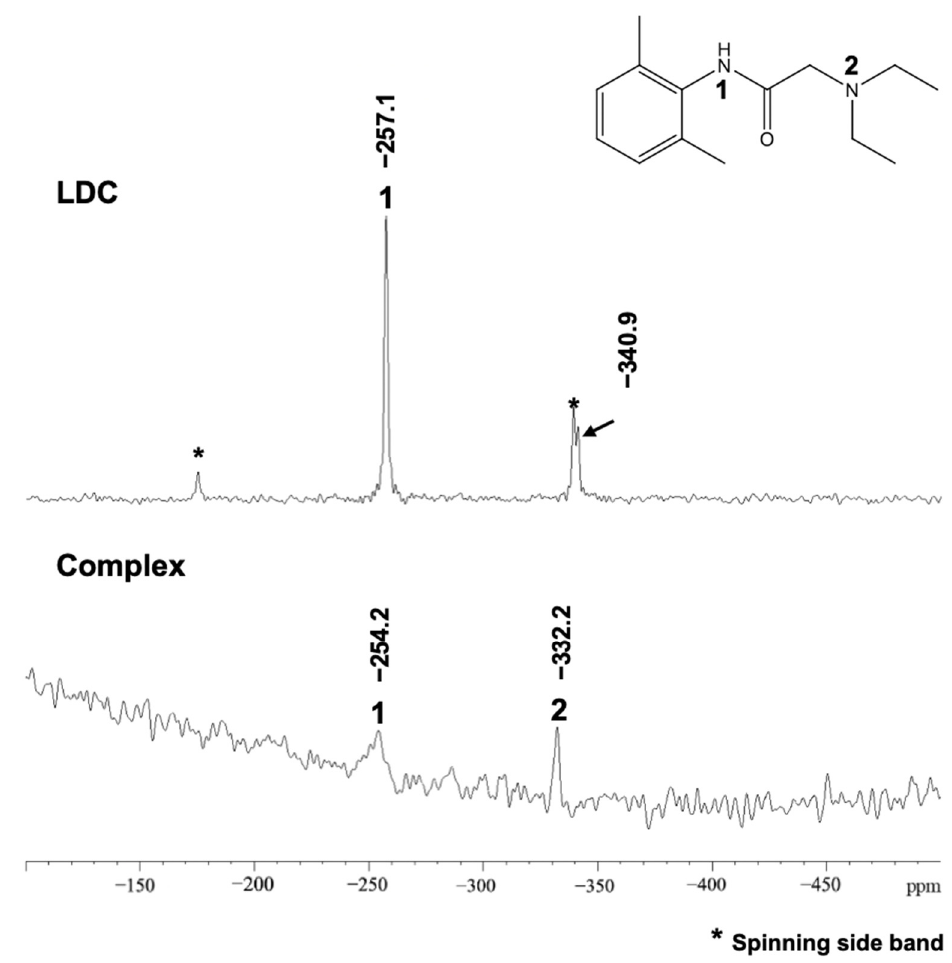
Figure 5. 15 N CP/MAS NMR spectra of FLU, LDC, and FLU/LDC complex.